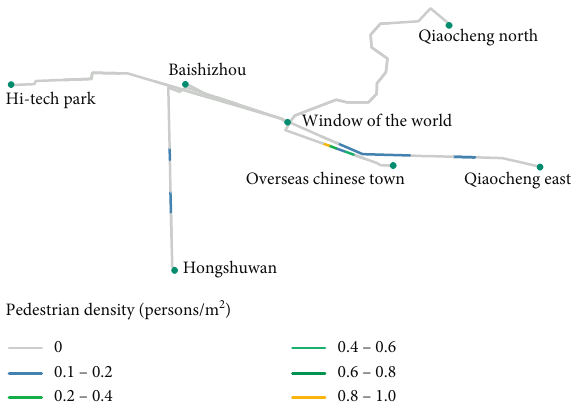
Figure 12: The pedestrian density on the roads at 18:30